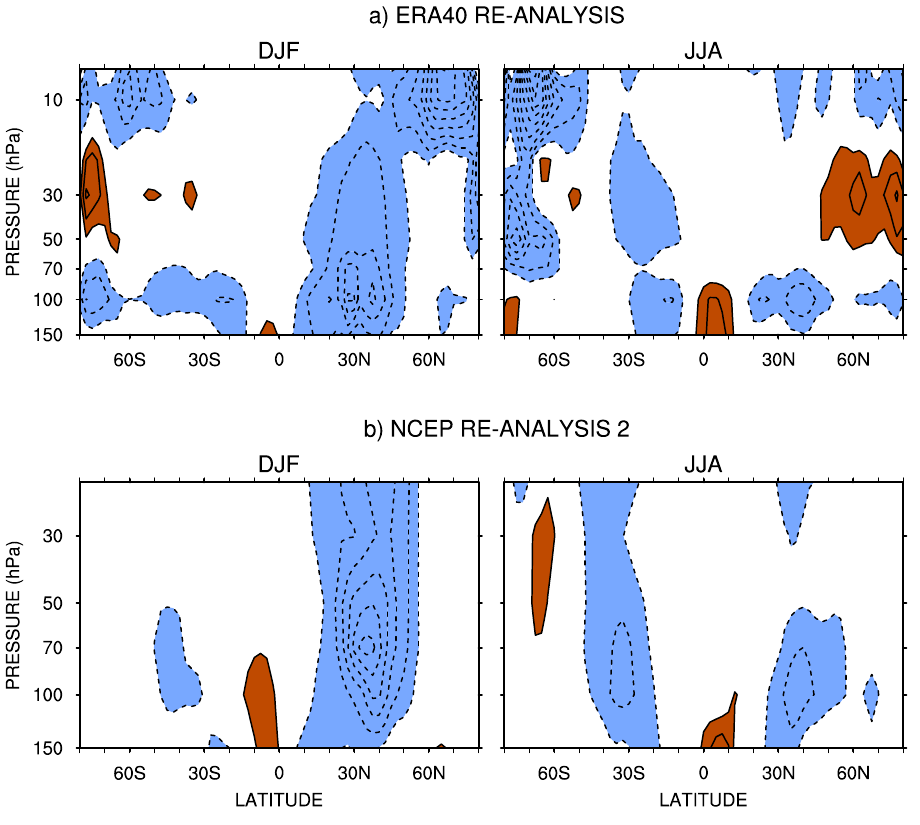
Fig. 3. Latitude-height cross-sections of the residual term in the TEM momentum equation averaged over DJF and JJA for the ERA-40 and R-2 reanalyses. Note that the R-2 reanalysis residual term is only shown up to 20-hPa. Dashed (solid) lines and blue (brown) shadings represent negative (positive) values. Contour interval is 0.5ms − 1 day − 1